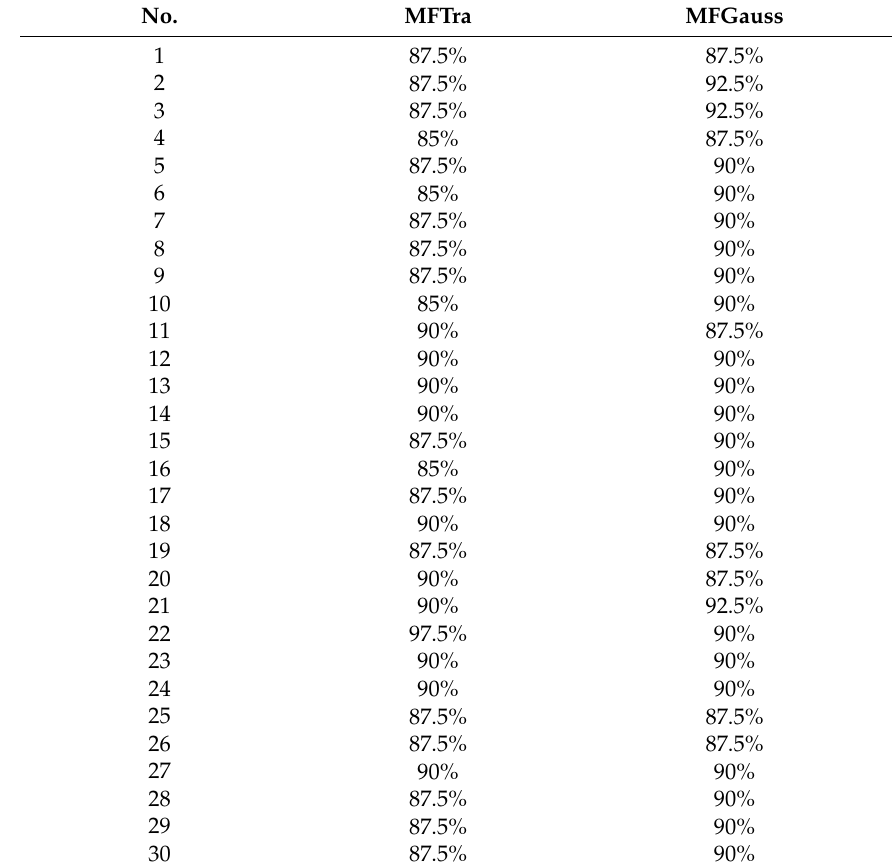
Table 5. Percentage of classification in each experiment with CSA.